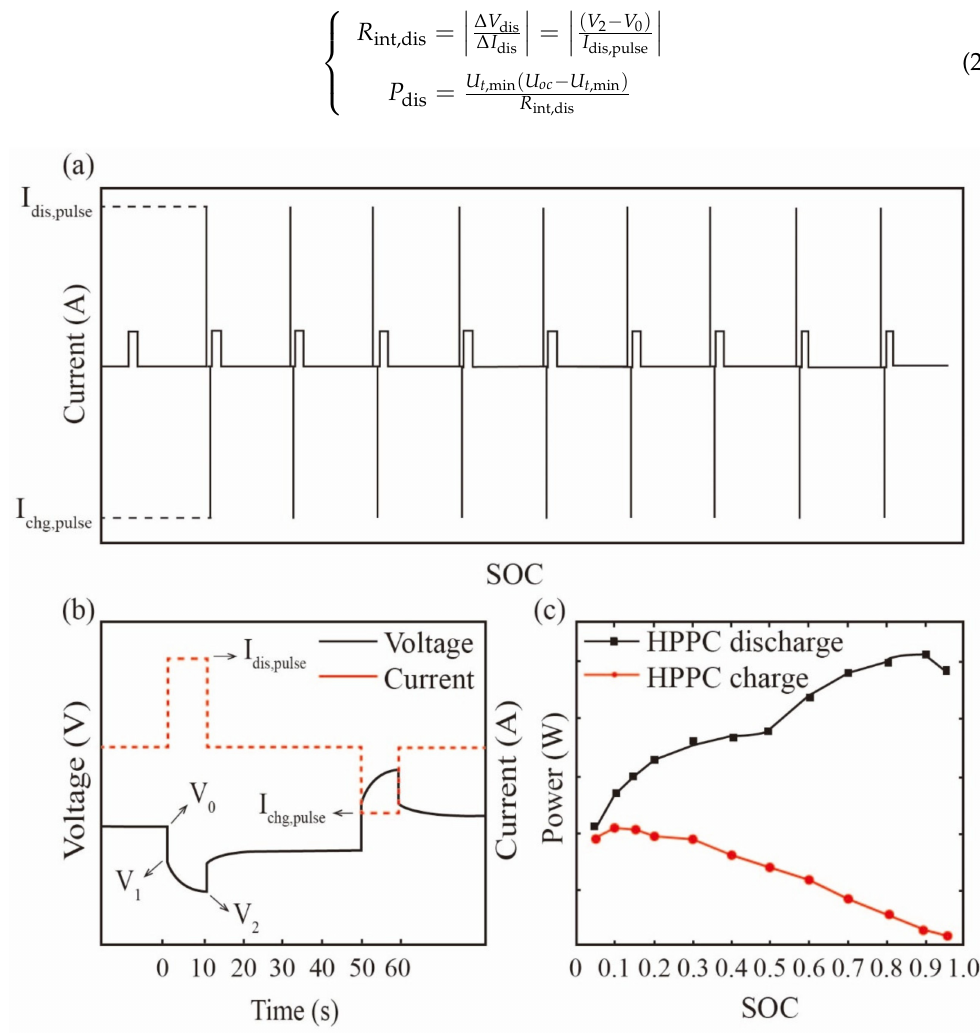
Figure 18. HPPC profile: ( a ) current profile; ( b ) typical current sequence and voltage response in a HPPC test; ( c ) instantaneous peak power through the HPPC